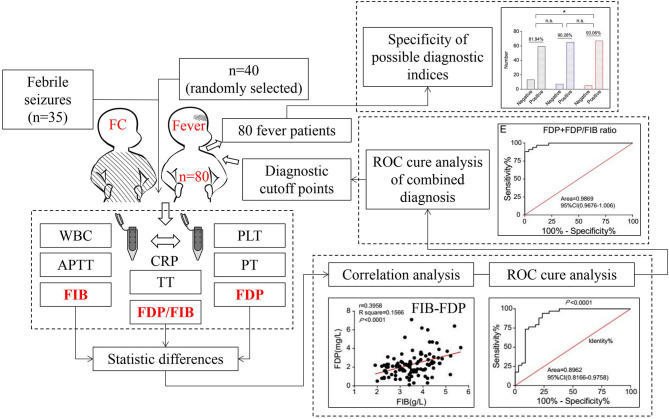
The overall scheme of this study.